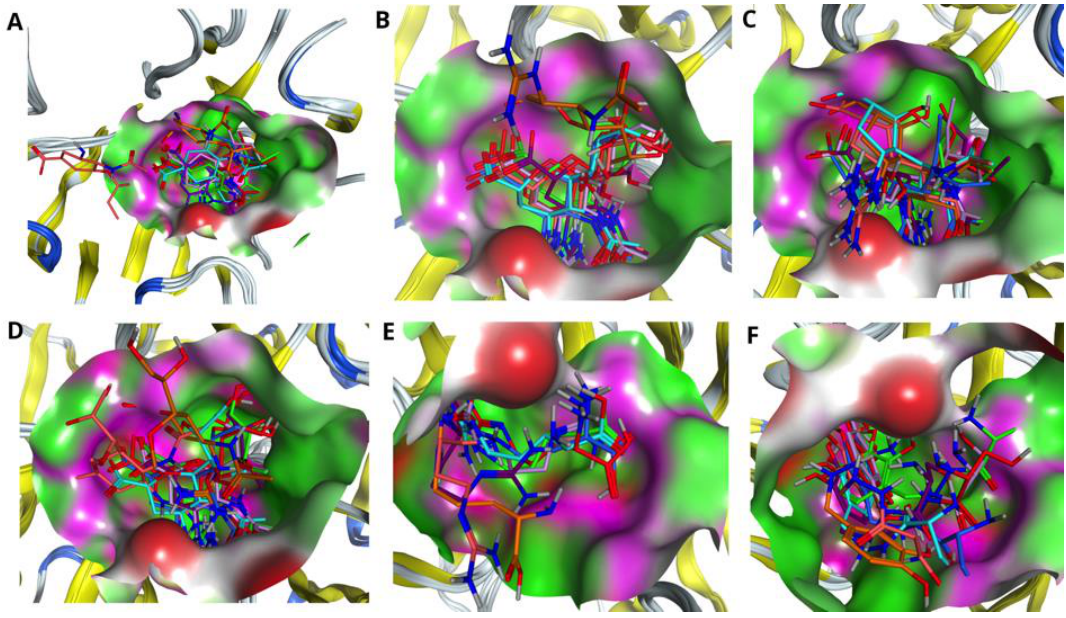
Figure 2. Comparing drug fit to wild type and mutated NA binding pockets. Superposition of ( A ) Oseltamivirs, ( B ) Zanamivirs, ( C ) Peramivirs, ( D ) Laninamivirs, ( E ) L-Arginines and ( F ) Benserazide hydrochlorides in the pockets of native NA (4MWQ) (red) as well as NAs with single (R294K) (cornflower blue), R119K (green), R372K (purple), double R294_119K (orange), R294_372K (turquoise), R119_372K (pink) and triple R294_119_372K (salmon) mutations. Table 6. The RMSDs (Å ) between the structures of the same drugs obtained from the docking to different pockets of N9 1 .